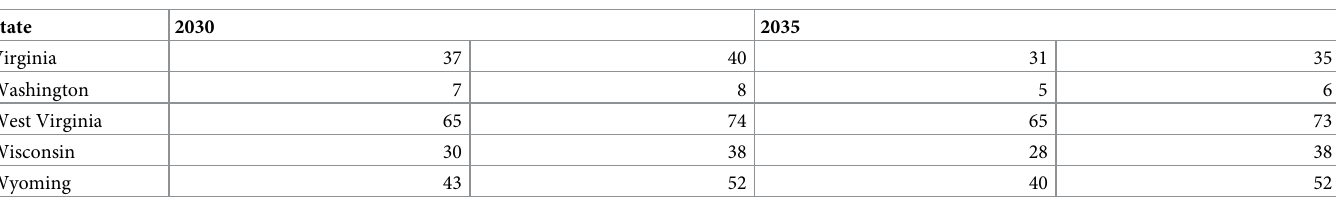
ppc = packs per capita per; Note: We took the values of ppc at the 25 th and 50 th percentiles of the simulated results as indication of “aggressive” and “realistic” target thresholds for 2030 and 2035.